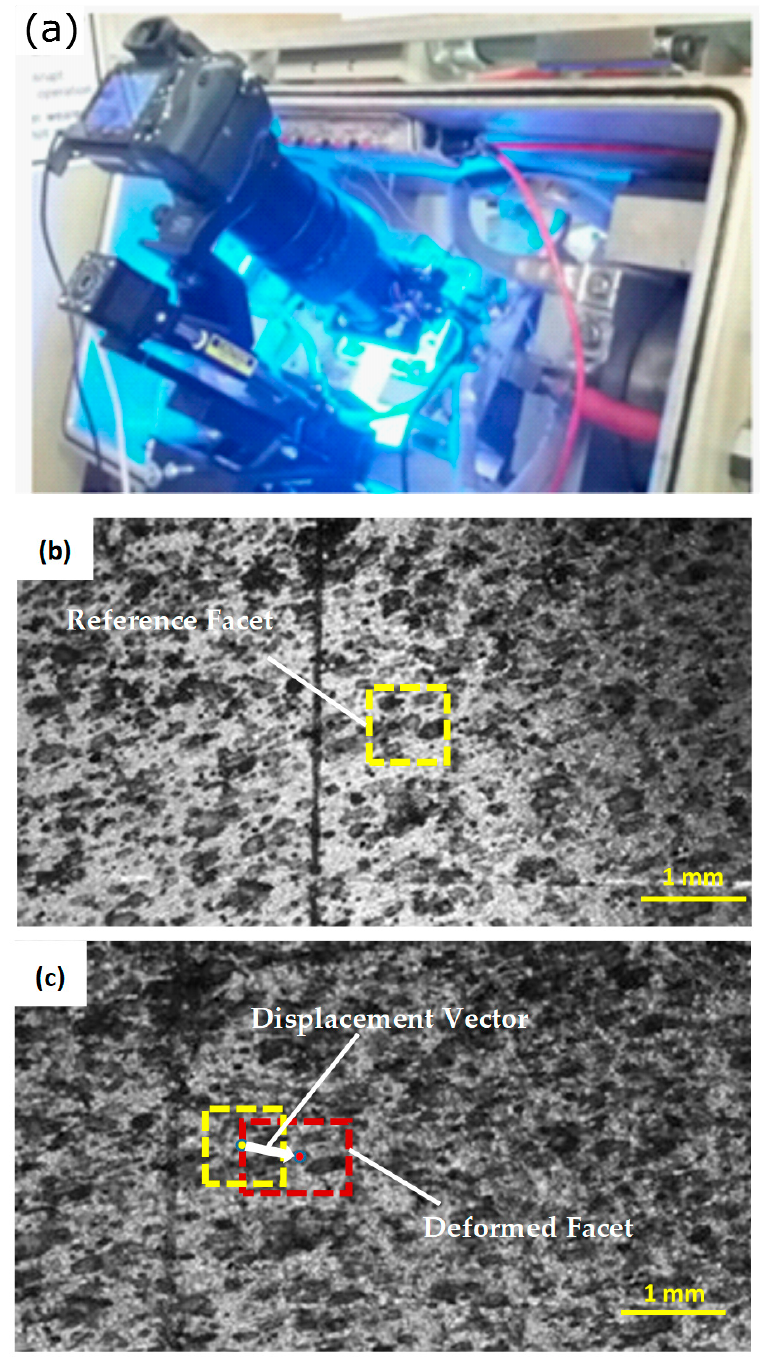
Figure 6. Tensile test setup with the camera: ( a ) its optical axis set perpendicular to the surface of the specimen, ( b ) a reference image acquired before tensile loading, and ( c ) a deformed image acquired after 62 s of tensile